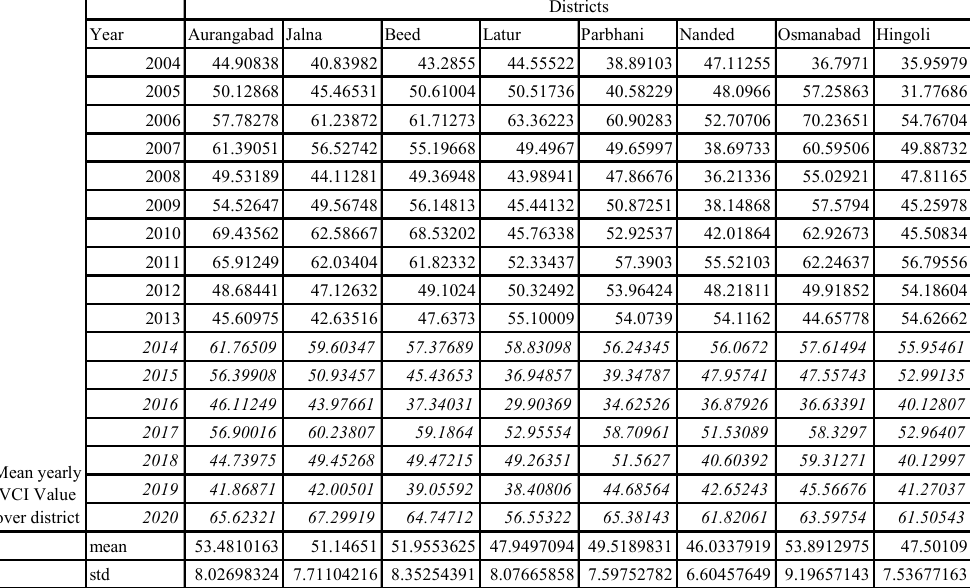
Table 2: Annual mean VCI over every district of Marathwada from 2004 to 2020